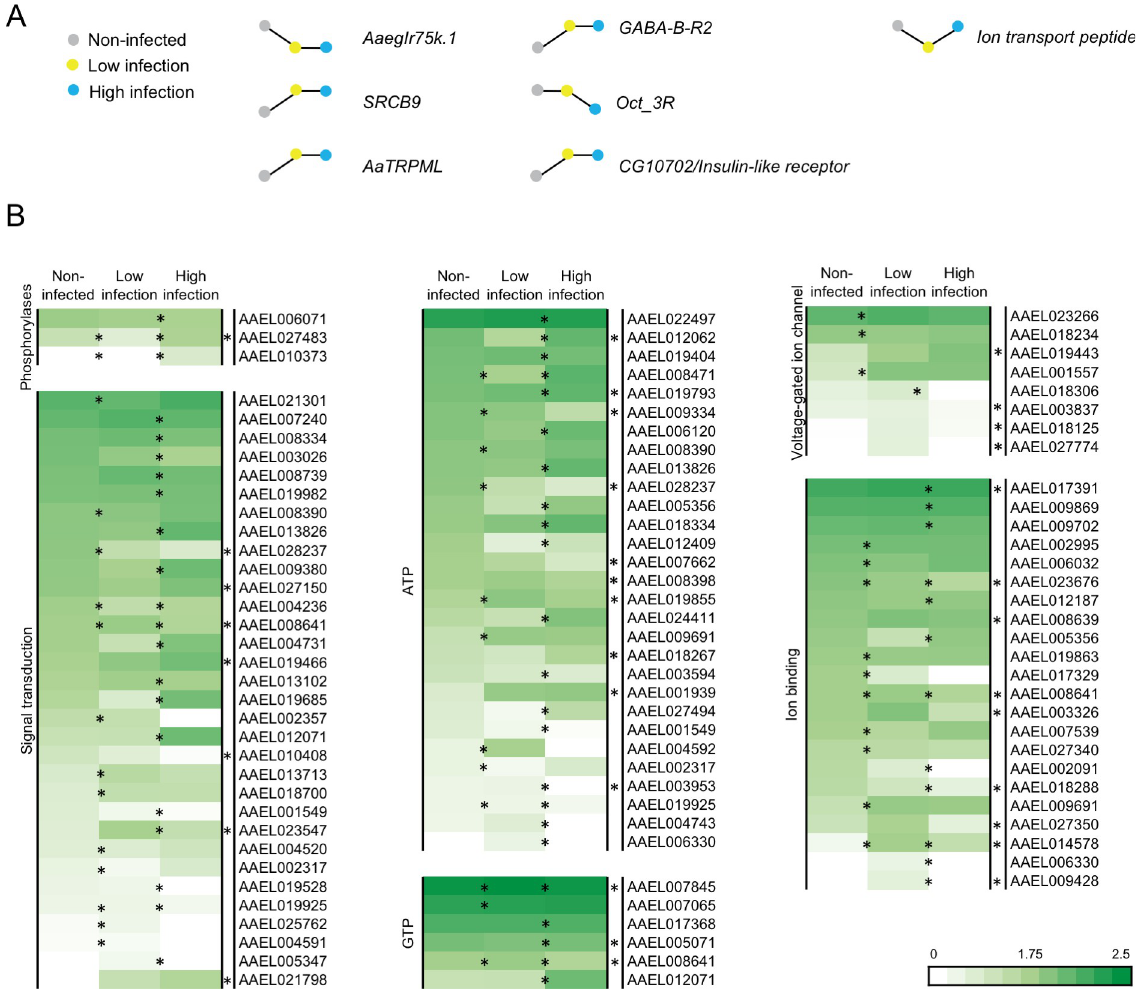
Fig 5. Dengue infection induces differential transcript abundances in key gene families. (A) Differentially abundant chemosensory (left) and neuromodulatory receptor (middle), and neuropeptide (right) genes, represented by stick and ball diagrams, indicating relative levels of abundance at different levels of infection. (B) The heat plots indicate differentially abundant neural signalling genes in the antenna of females with different levels of infection. Significantly different abundance is indicated by asterisks between conditions (fold change > 2; FDR- corrected P < 0.05). An asterisk on the far right of the heat plots indicates comparisons between non-infected and highly infected